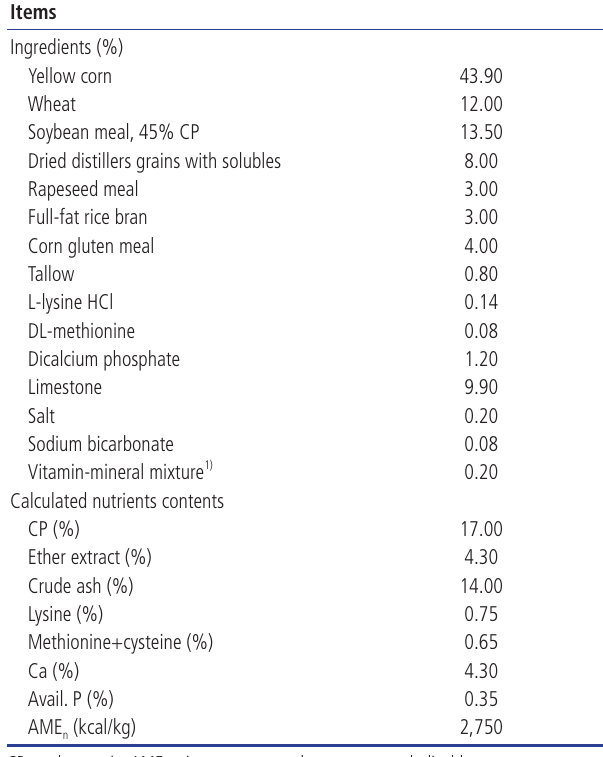
Table 1. Formula chemical composition of control